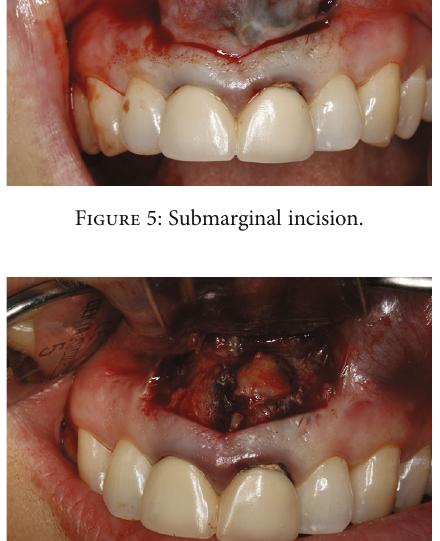
Figure 9: Endoscopic view of 2.1 before removal of the old fi ller material.